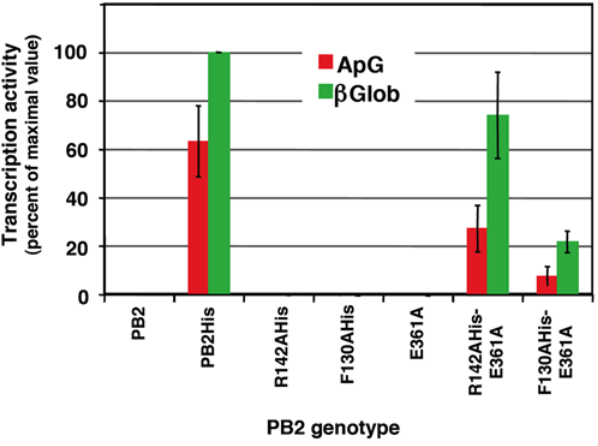
Figure 2. Phenotype of trans -complemented RNPs. The purified RNP preparations presented in Fig. 1 were tested for in vitro transcription primed with either ApG (red) or b -globin mRNA (green). The data are presented as percent of maximal value and represent the averages and ranges of two independent complementation experi- ments. The transcription activities parallel the values of NP accumula- tion presented in Fig. 1 and show that the rescued RNPs have a wt cap- snatching